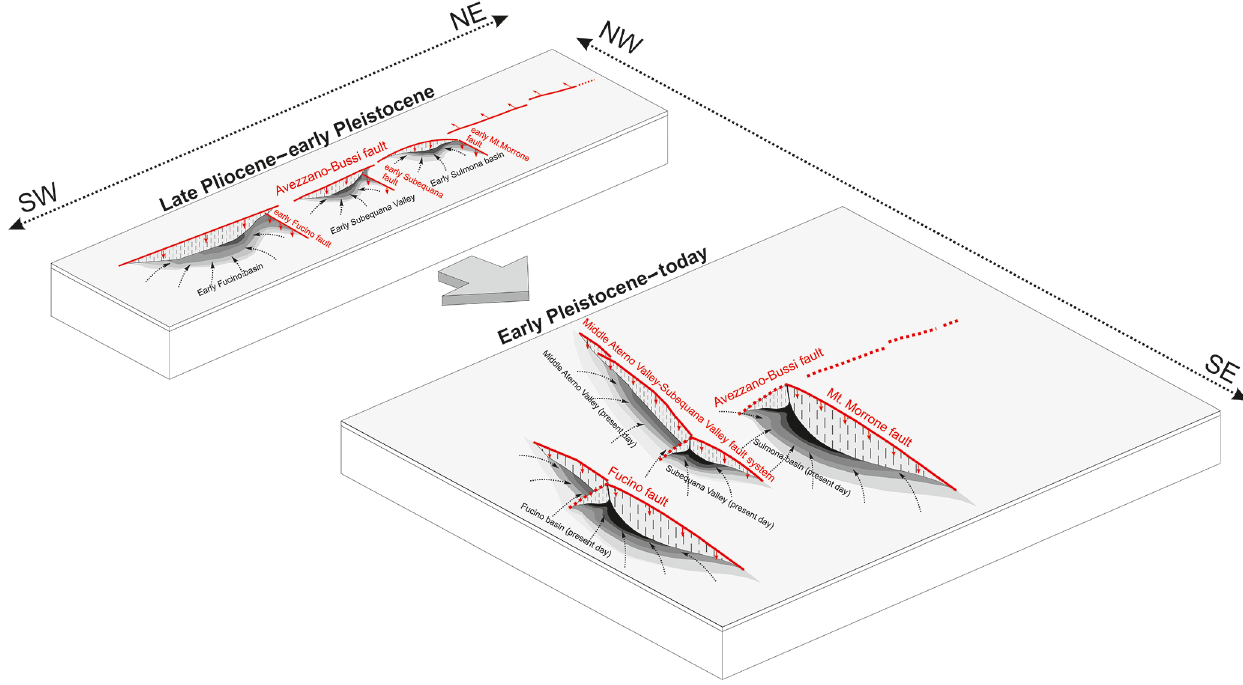
Figure 9. Scheme of the late Pliocene-to-present structural evolution of the Fucino Basin, Subequana Valley, and Sulmona